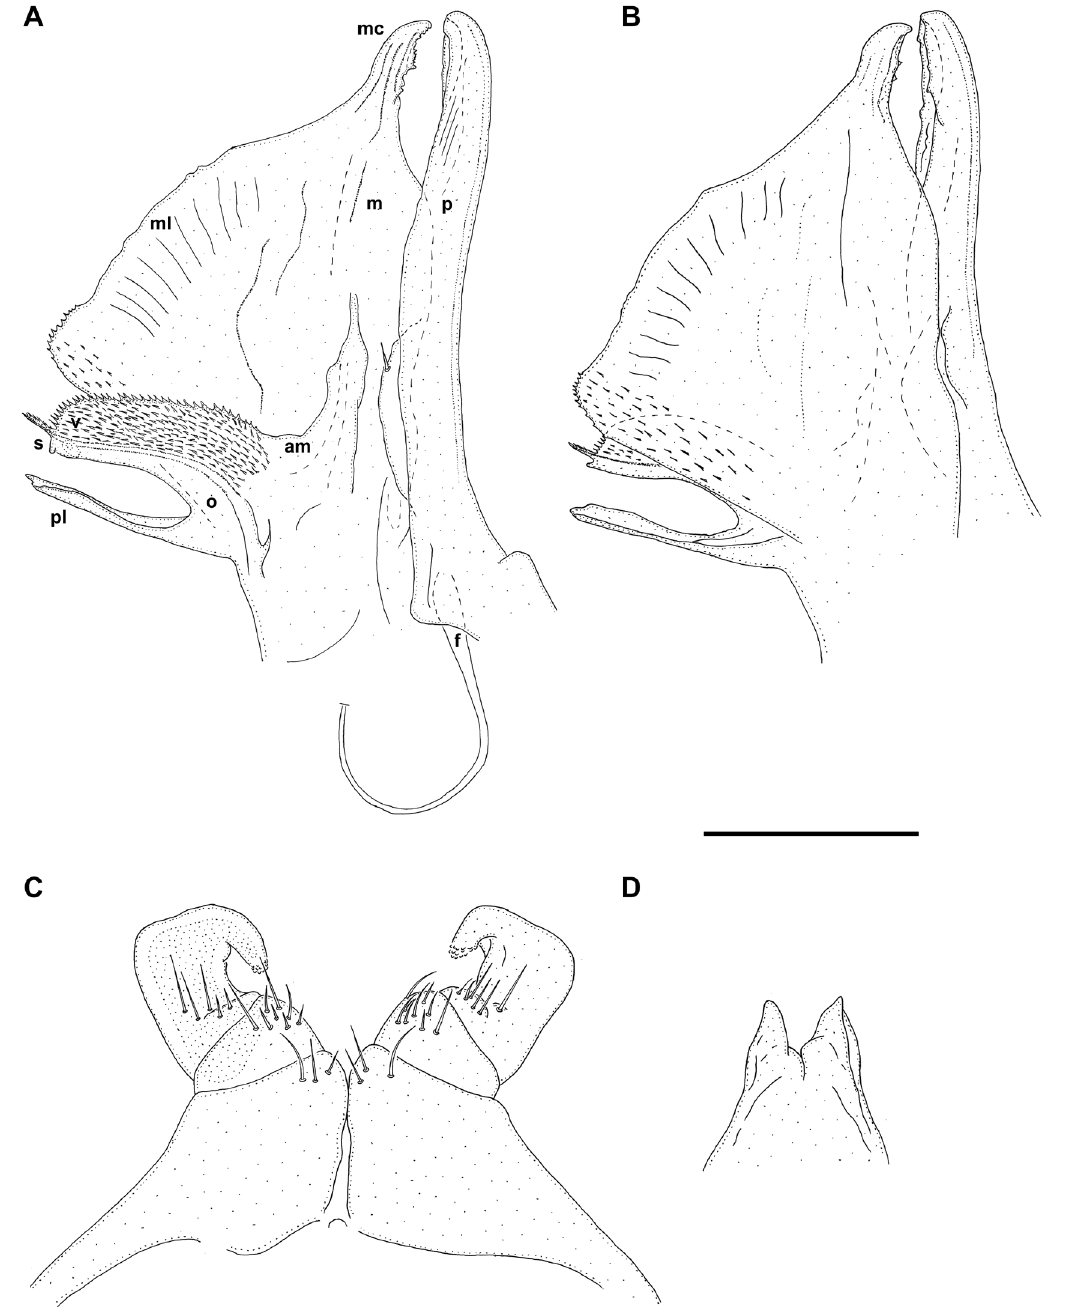
Fig. 43. Leucogeorgia profunda sp. nov., paratype ♂ from Krubera Cave (ZMUM). A . Right gonopods, mesal view. B . Left gonopods, lateral view. C . Leg-pairs 1, anterior view. D . Penes, posterior view. Abbreviations: am = accessory membrane; f = flagellum; m = mesomere; mc = mesomeral claw; ml = mesomeral lamella; o = opisthomere; p = promere; pl = protective lamella; s = solenomere; v = velum. Scale bar: 0.3